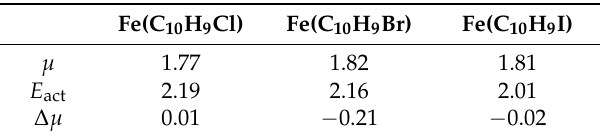
Table 3. Dipole moment ( µ , D) of isolated metallocene molecules with an eclipsed configuration; activation energy ( E act = E transition state − E ground state , kJ/mol) and dipole moment difference ( ∆ µ = µ transition state − µ ground state , D) between the transition state and the ground state. The number of 3 d electrons on Fe is 6, and the magnetic moment of each isolated molecule is 0.